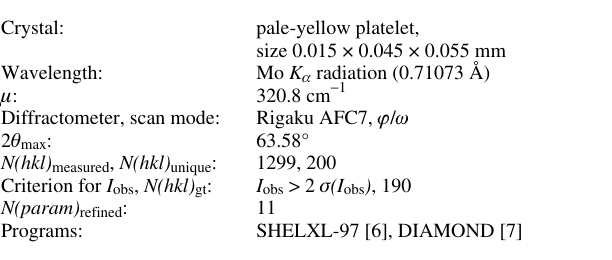
Table 2. Atomic coordinates and displacement parameters (in Å 2 ) for the composition Eu 2 [BN 2 ]Br